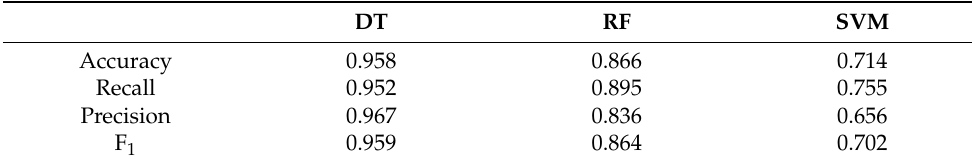
Table 4. Comparison of classifier performance using evaluation